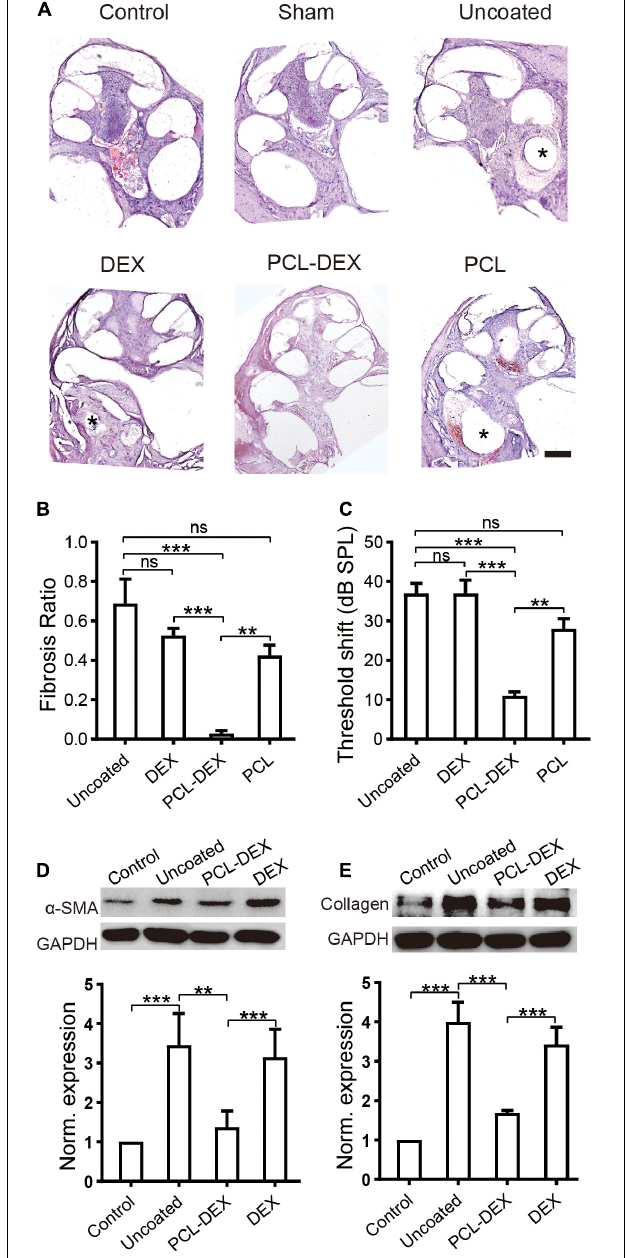
FIGURE 5 | PCL-DEX electrode alleviates fibrosis after CI. (A) Optical microscopy images show representative H&E-stained cross sections of the cochlea before (control) and 5 weeks after different implantation procedures. “Sham” for cochlea 5 weeks after sham surgery. “Pristine” for pristine electrode implant. “DEX” for pristine electrode implantation with one dose of DEX applied via a round window. “PCL” for implantation with a PCL-coated electrode containing no DEX. “PCL-DEX” for implantation with a PCL-coated electrode containing 20% DEX. Scale bar = 500 µ m for all panels. (B) The fibrosis ratio 5 weeks after different implant procedures. (C) The ABR threshold shift at 2 kHz 5 weeks after different implantation procedures. The data in panels (B , C) are presented as the mean ± SE. ns: no significant difference, p > 0.05; * p < 0.05; ** p < 0.01; *** p < 0.001, Student’s t